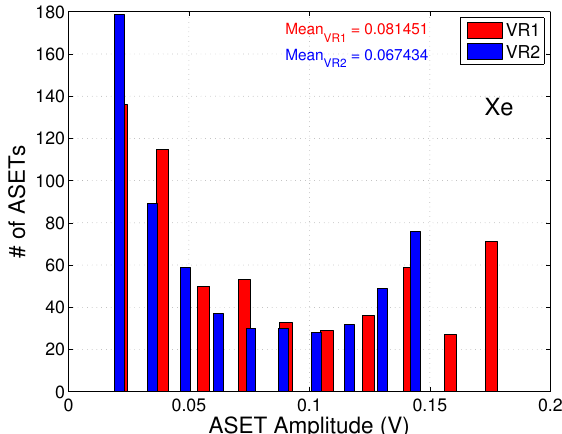
Figure 11. Measured number of ASETs versus ASET’s peak amplitude for VR1 and VR2 circuits when exposed to